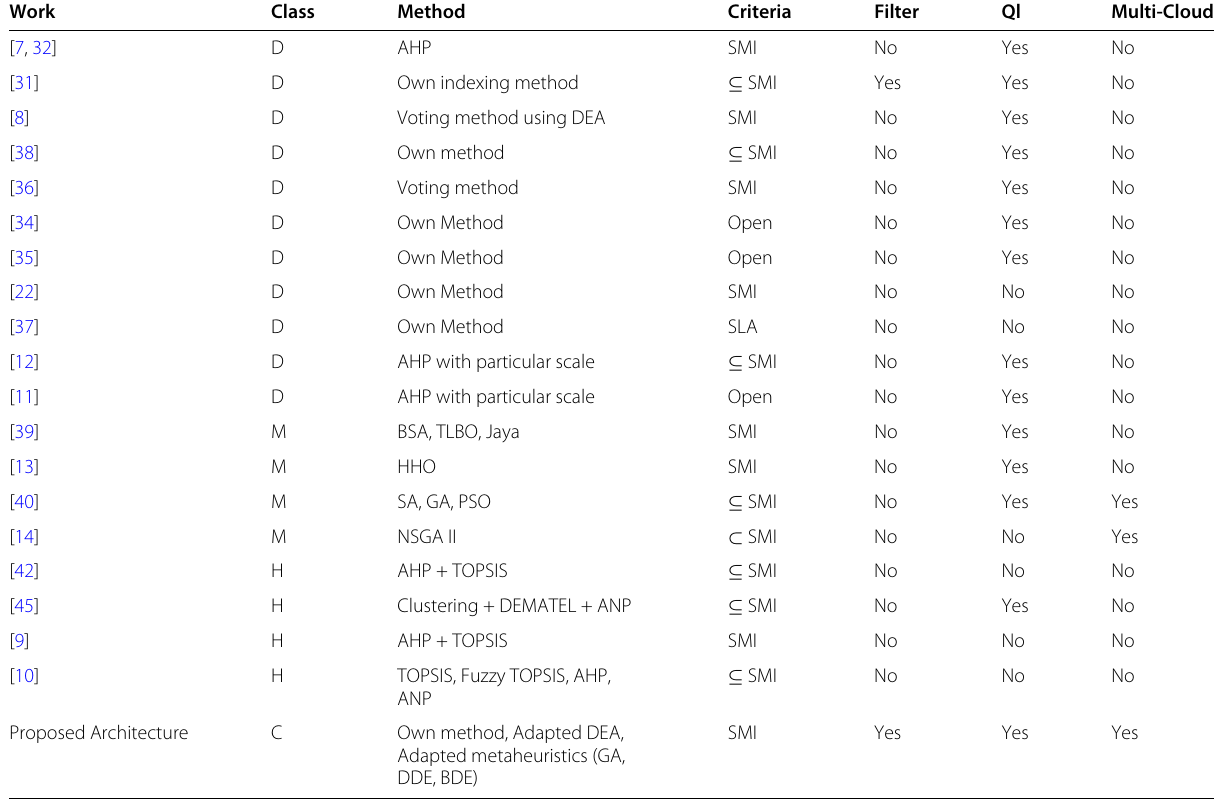
Table 1 Overview and comparison between cloud providers rank and selection proposals Work Class Method Criteria Filter Ql